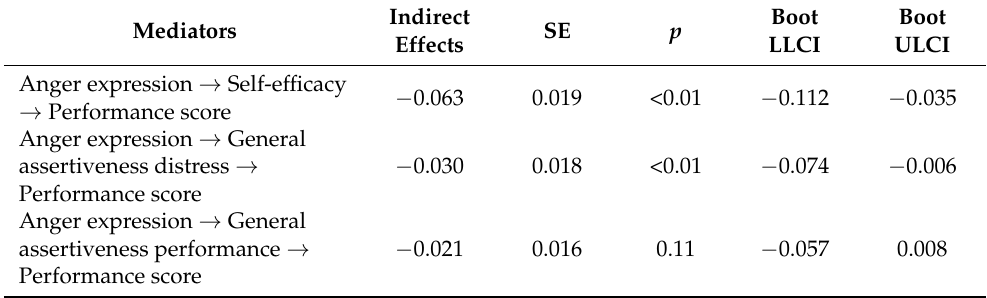
Table 3. Summary of indirect effects and confidence intervals of three mediators (Parents).